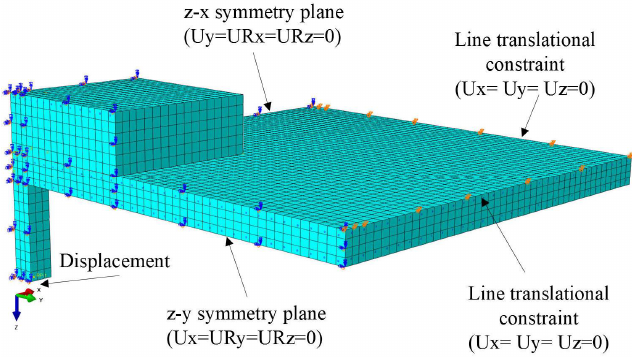
Figure 10. FE model for specimen ZM01. Table 4. Material properties of concrete.